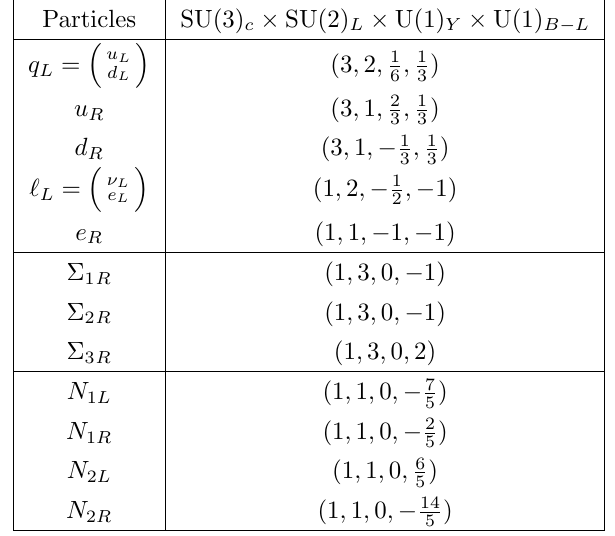
Table 1 . Fermionic (cid:12)elds of the present Model including the SM fermions. Particles